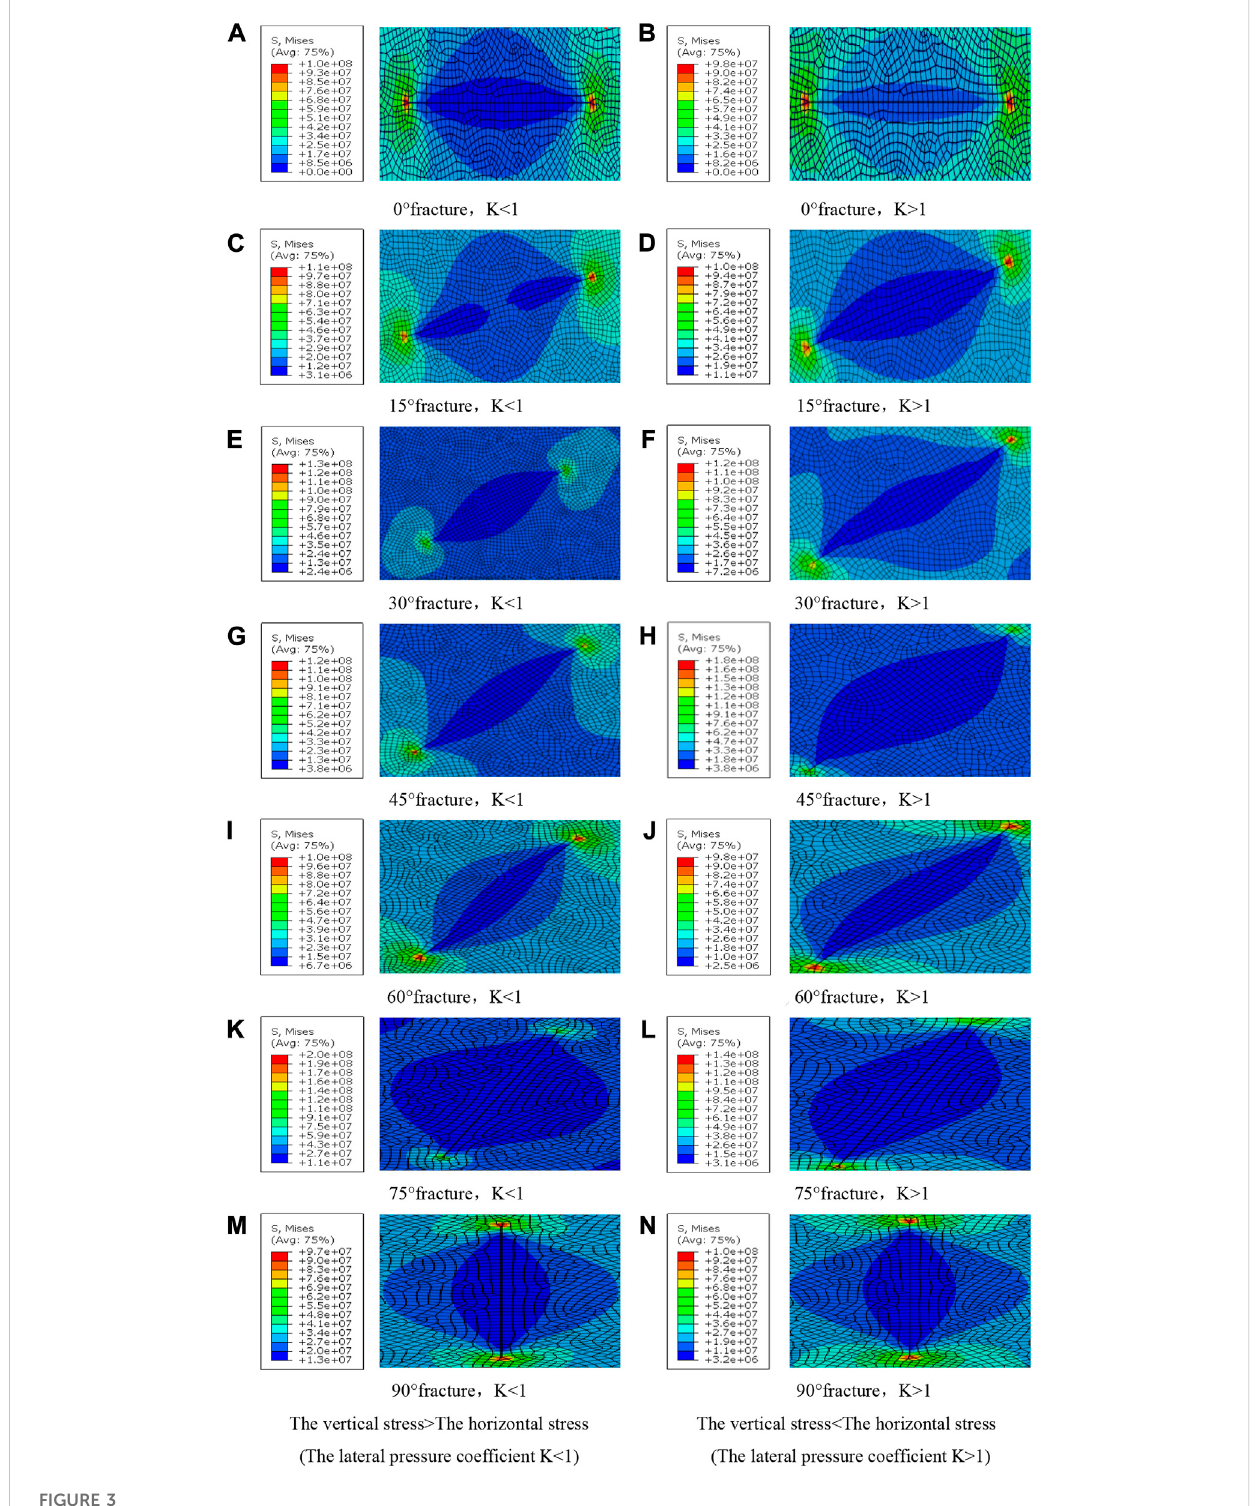
Stress nephogram of fractures with different angles under stress in two